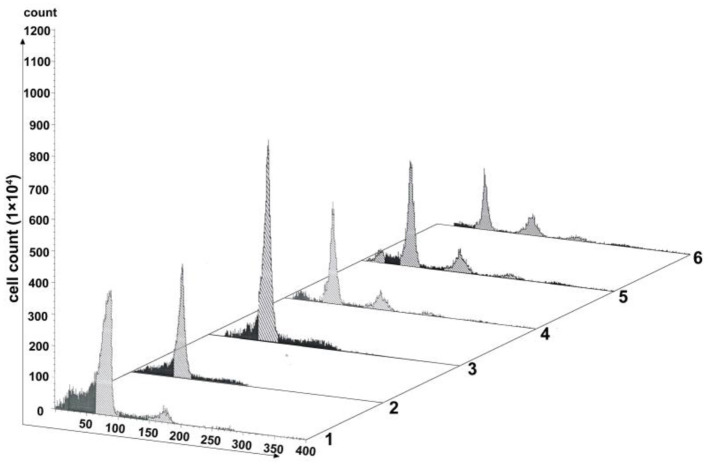
Analysis of cell proliferation by flow cytometry after transfection with pAd-MAD2. Lane 1 represents the normal cultured group. Lane 2 represents the negative control group. Lanes from 3 to 6 represent the overexpressed MAD2 groups (OE-MAD2): the cells being transfected with pAd-mCMV-MAD2-GFP-3-Flag-pA for 72 h (Lane 3), the cells being treated with SP600125 for the next 48 h (Lane 4), the cells continued to be further cultured in SP600125-free medium for 12 h (Lane 5), and the cells being further cultured using SP600125 treatment for another 48 h (Lane 6).